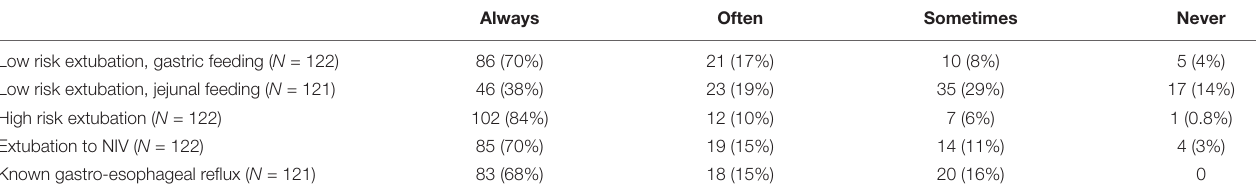
TABLE 1 | Fasting prior to extubation in PICU specific circumstances.